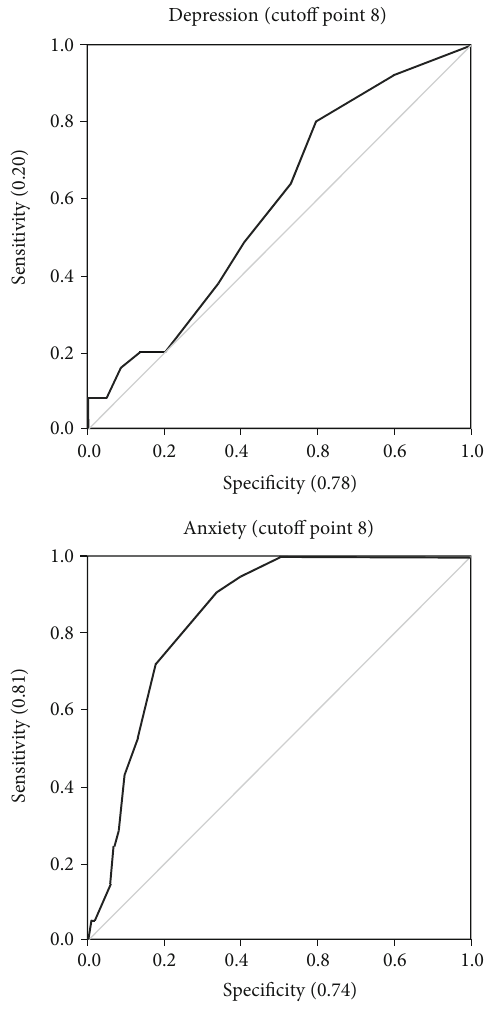
Figure 1: For the depression ROC curve, the following values were determined with the 8 cut-o ff point: false positive rate (0.22), false negative rate (0.80), positive predictive value (0.23), and negative predictive value (0.76). For the anxiety ROC curve, the following values were determined with the 8 cut-o ff point: false positive rate (0.17), false negative rate (0.38), positive predictive value (0.48), and negative predictive value